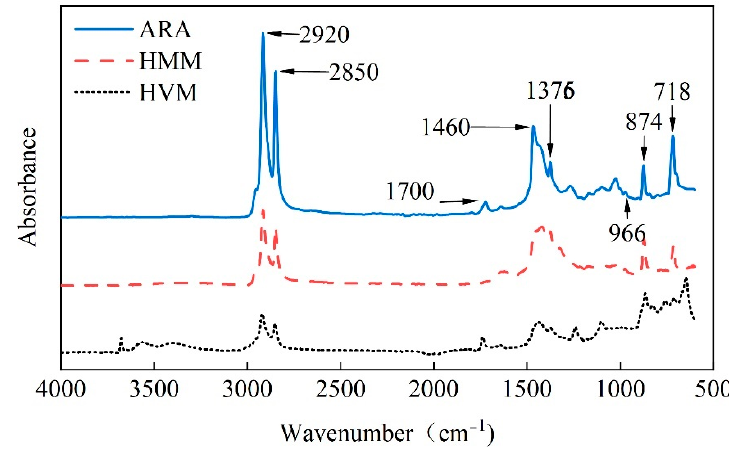
Figure 2. FTIR spectra of different modifiers.